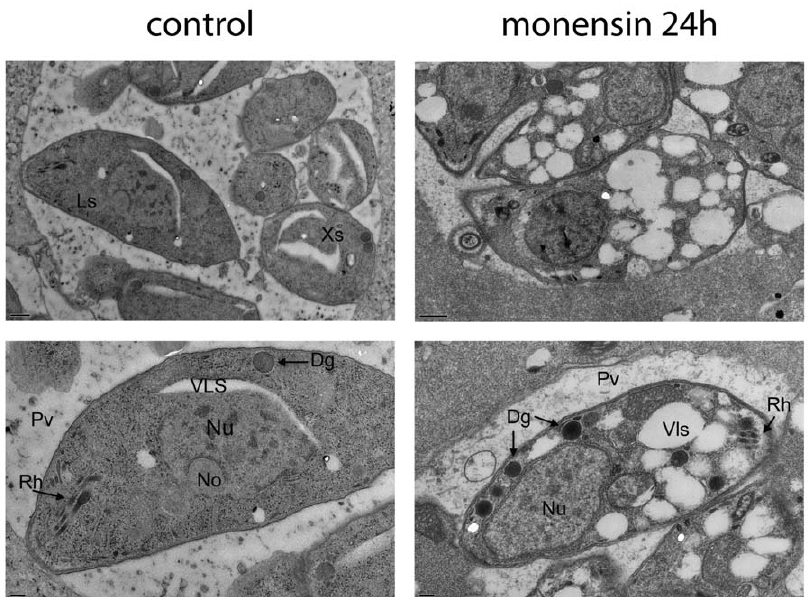
Figure 2. Monensin induces formation of vacuole like structures in T.gondii . Transmission electron micrographs of intracellular T. gondii after 24 hours exposure to 0.75 ng/ml monensin. Ls, longitudinal section through parasite; Xs, cross-section through parasite; Pv, parasitophorous vacuole; Rh, rhoptries; Nu, nucleus; No, nucleolus; Dg, dense granule; Vls, vacuole-like structure. Scale bar (bottom left)=0.5 m M.